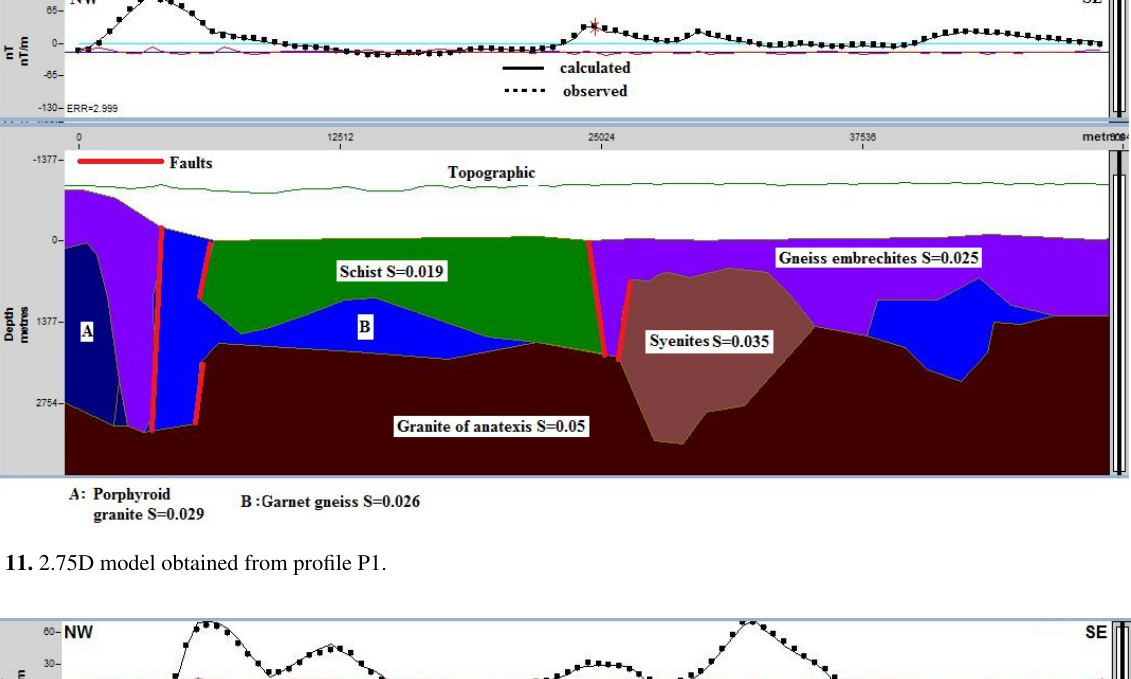
Figure 11. 2.75D model obtained from profile P1.